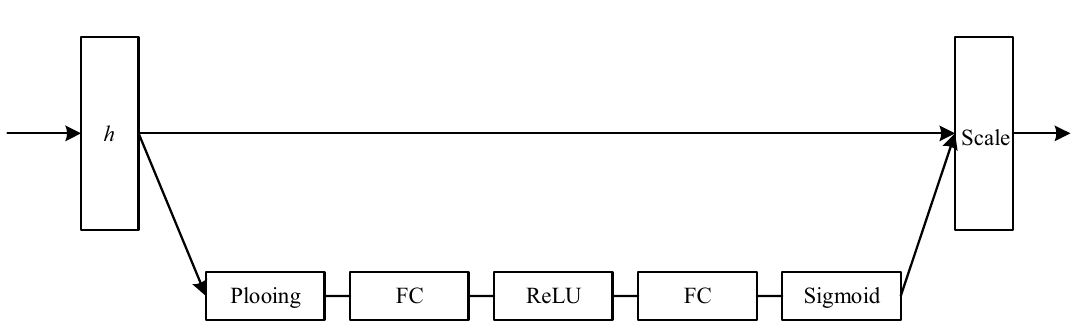
Figure 3. The Lambda-SE module of the Lambda-vector architecture.